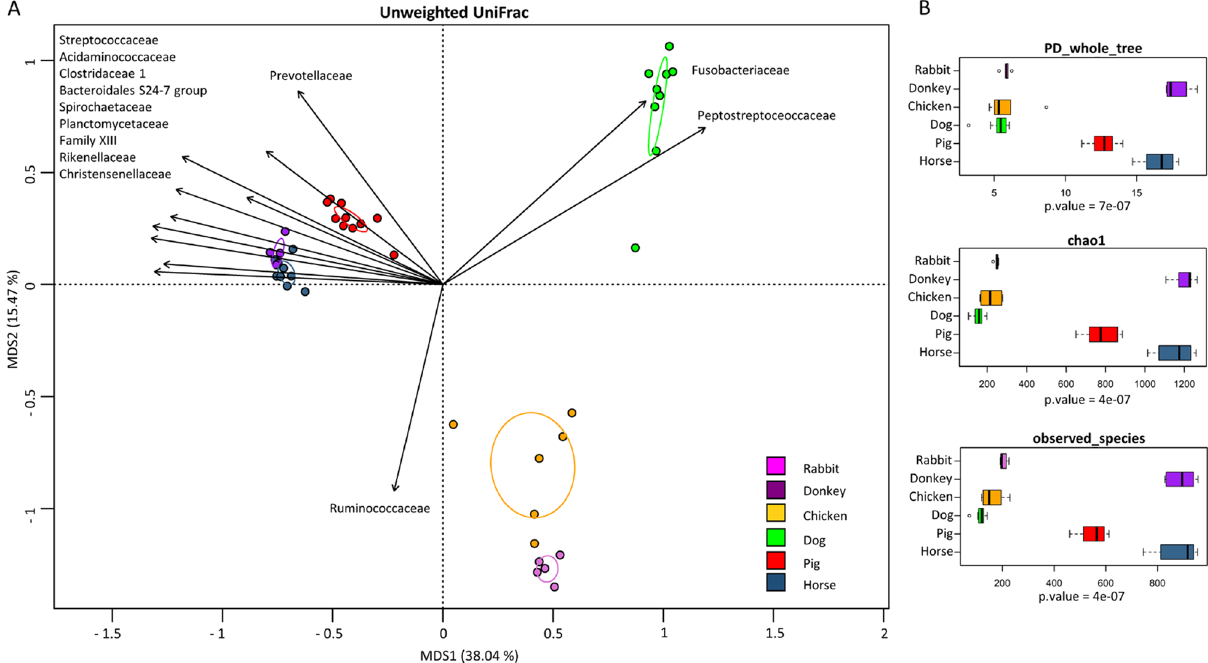
Figure 5. Diversity of the farming animals’ gut microbiota. PCoA of the unweighted UniFrac distances showing ( A ) all samples, a significant separation among animal groups was observed (permutation test with pseudo-F ratios (Adonis); p < 0.001). Black arrows were obtained by fitting the relative abundance of bacterial families for each sample within the ordination space (function envfit of the vegan R package). ( B ) Boxplots showing alpha diversity values according to the different metrics: Faith’s phylogenetic diversity (PD_whole_tree), Chao1 index and OTU species count (observed_species). All metrics showed a significantly higher gut microbiota diversity for Donkey, Pig and Horse (Wilcoxon rank-sum test; p <